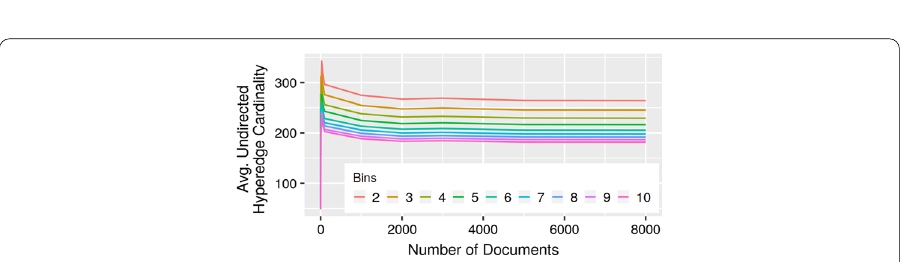
Fig. 25 Average hyperedge cardinality over time, per number of bins, for the TF-bins